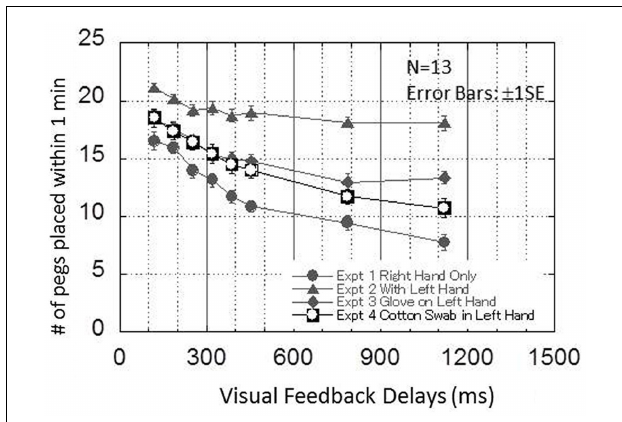
FIGURE 7 | Results obtained in experiment 4. This graph plots the performance of the pegboard task as a function of the visual delays from 120 to 1120ms in eight steps.The results obtained by the same 13 participants in experiments 1, 2, and 3 are superimposed on the